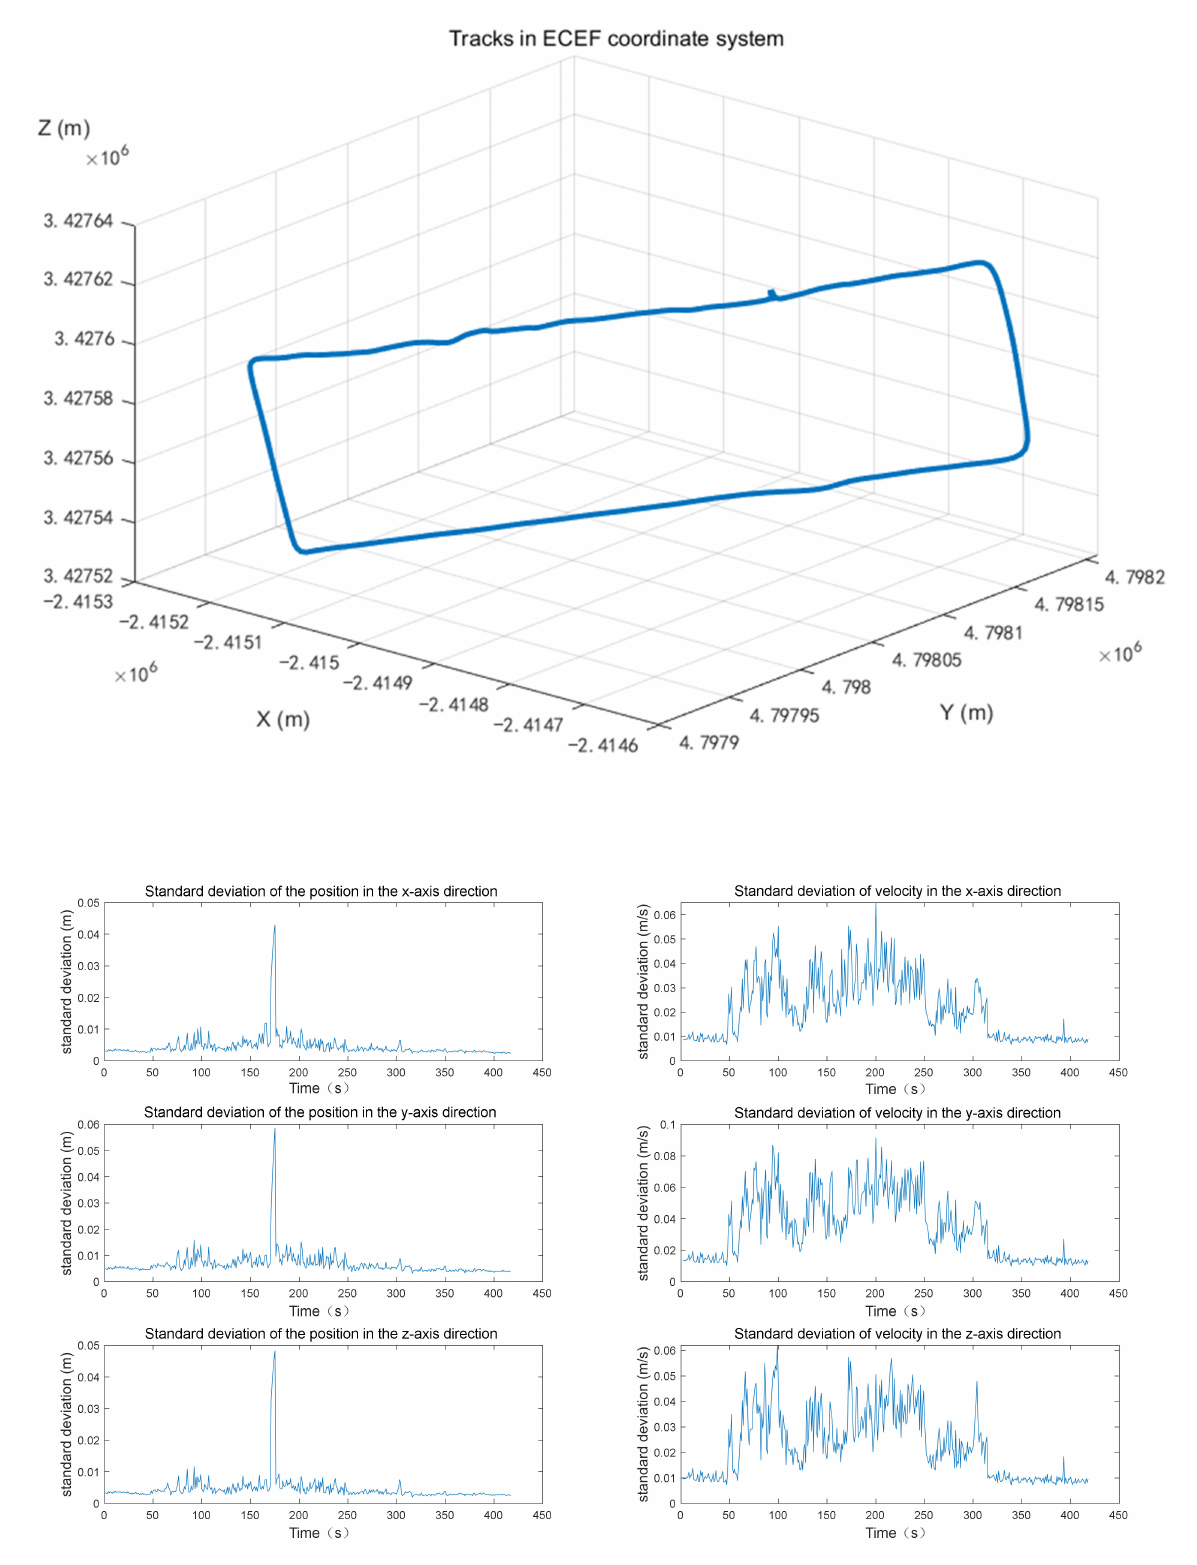
Figure 9. Analysis in ECEF coordinate